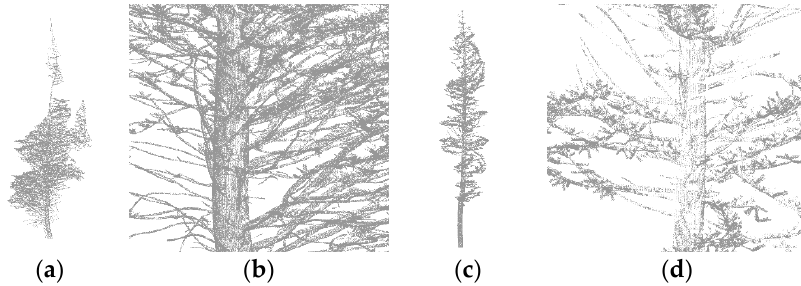
Figure 1. Examples of simulated point clouds from the Newfoundland data set. Even though the point clouds were noise-free, they suffered from branch occlusion. ( a ) Isolated tree; ( b ) Close-up view of branches; ( c ) Isolated tree; ( d ) Close-up view of branches.